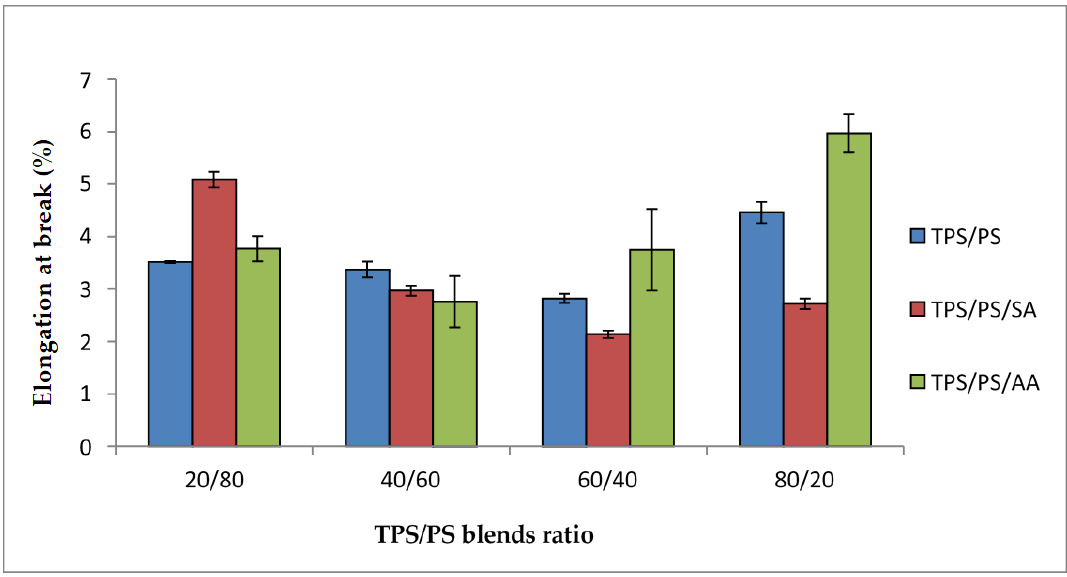
Figure 6. Elongation at break tensile of treated TPS/PS with AA and SA at different blend ratios.